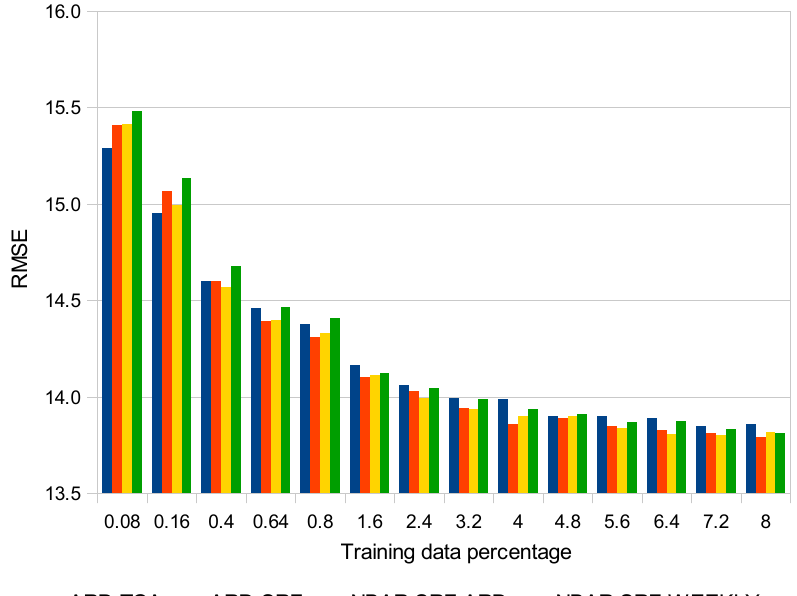
Figure 3. Root mean square error (RMSE) accuracy results derived as (2) for the four data processing levels using top of atmosphere ARD (TOA ARD), atmospherically corrected ARD (SRF ARD), BRDF adjusted atmospherically corrected ARD (NBAR SRF ARD), and weekly composited BRDF adjusted atmospherically corrected ARD (NBAR SRF WEEKLY). The results considering an increasing percentage of the training data are shown.